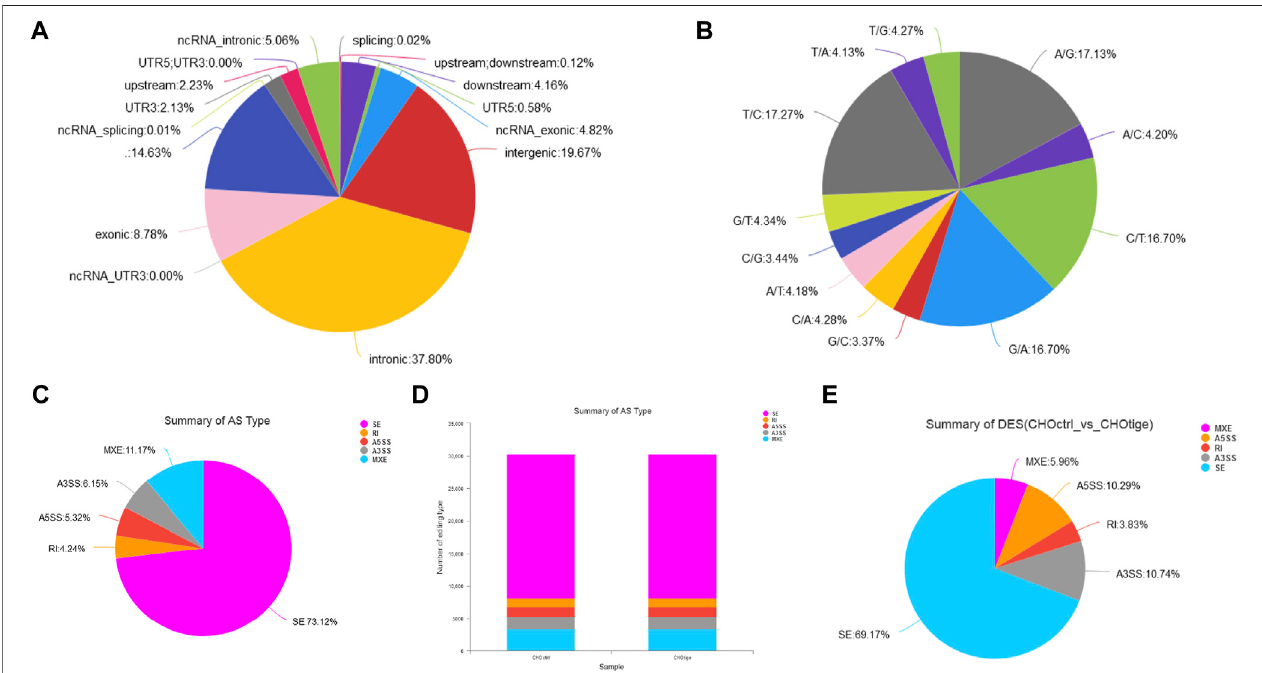
FIGURE5 | The analysisof SNPs and AS events ofCHO cells with tigecycline treatment byRNA-sequencing. (A) TheSNP distribution in genome regions. (B) The summary of SNP types in CHO cells with tigecycline treatment. (C) The statistics of AS events in one sample. (D) The statistics of AS events in two groups. (E) The statistical pie chart of types of AS